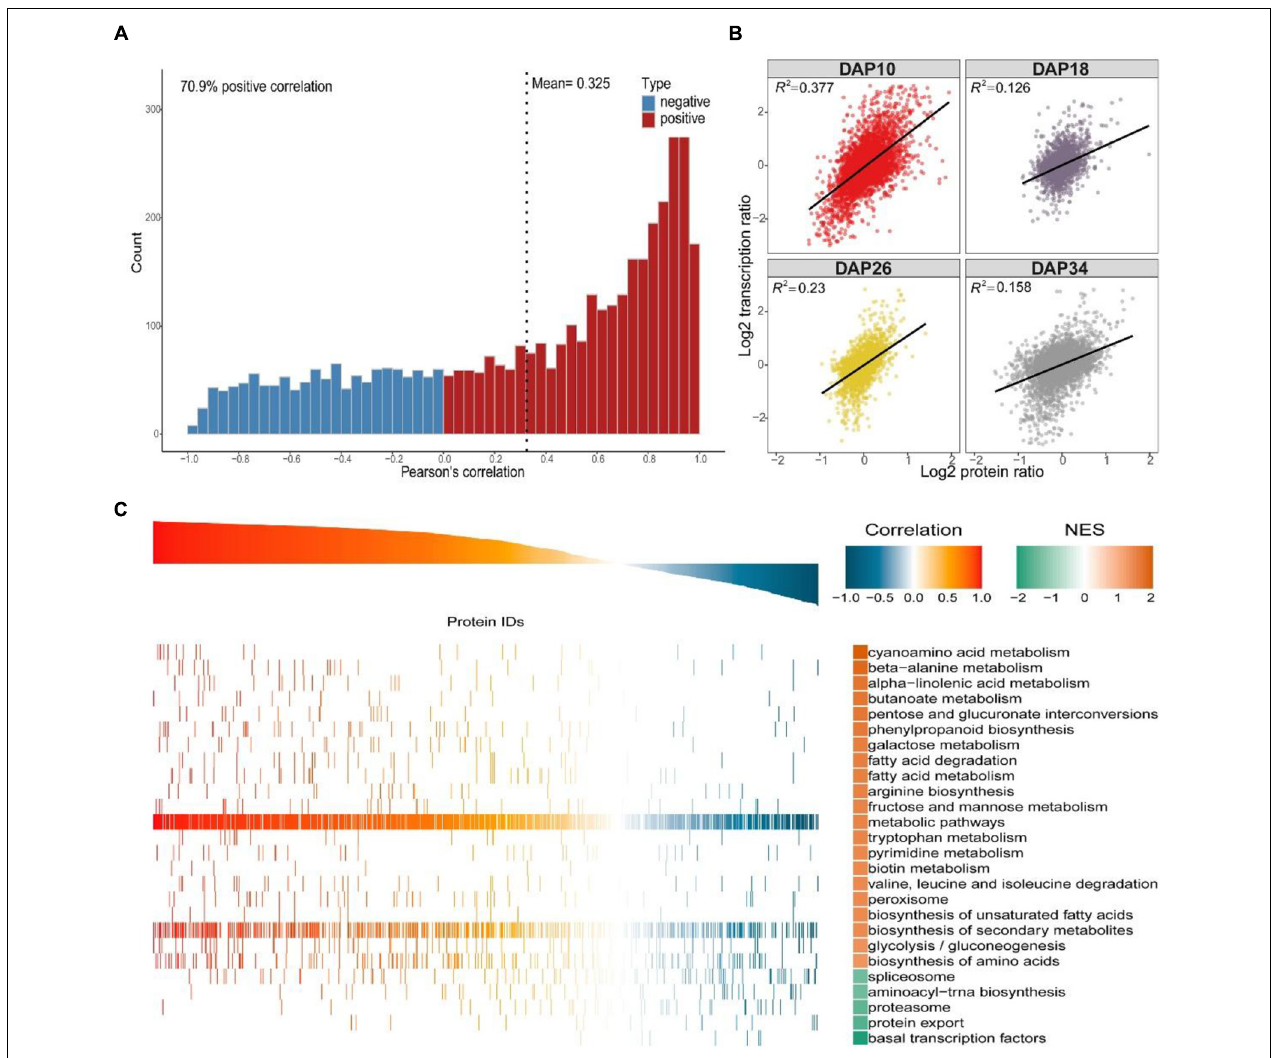
FIGURE 4 | Integrative analysis of the proteome and transcriptome. (A) Pearson correlation analysis of overlapping differentially expressed proteins/genes. In total, 70.9% of genes were positively correlated, and the mean Pearson correlation coefficient was 0.325. (B) Correlation plots obtained at each of the four stages, and data were log-transformed before analysis. Correlation coefficients ( R 2 ) were given on top of each plot. (C) GSEA of global mRNA-to-protein correlation and enrichment analysis of the corresponding gene